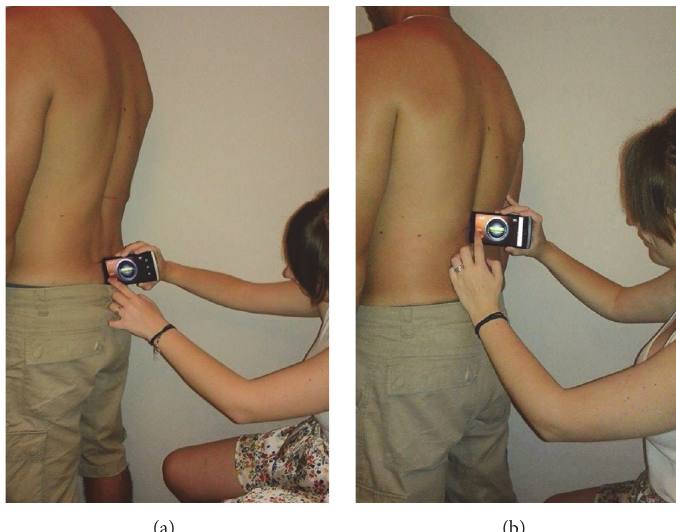
Figure 1: Sacral slope and lumbar curve measurement technique with the smartphone placed at (a) S1-S2 interspace and (b) T12-L1